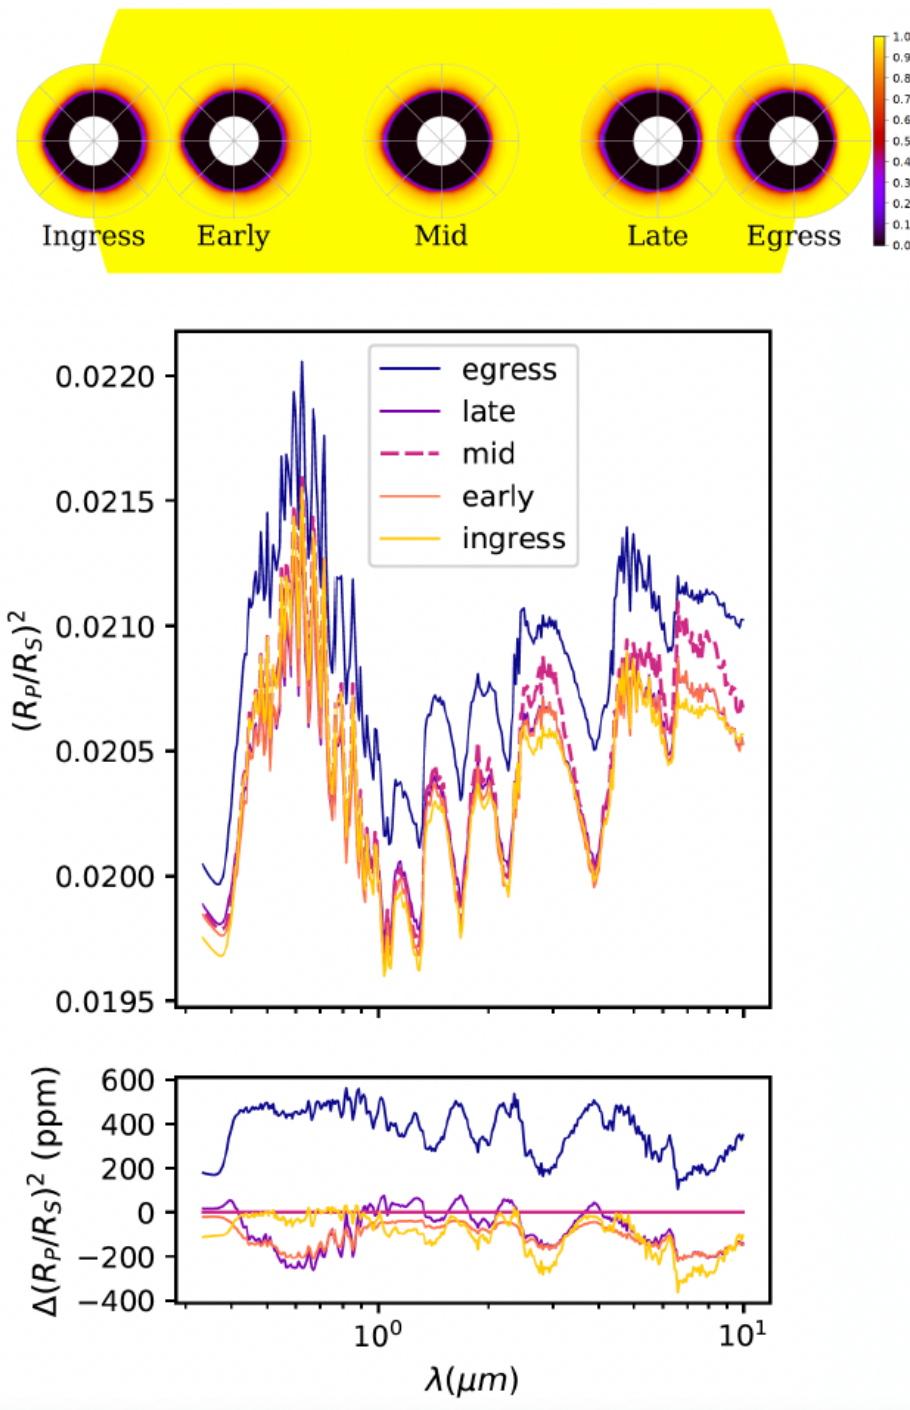
Figure 8. ( Top ) Transmittance maps of WASP-121b at 0.6 microns. The orbital phase angle is − 15 degrees for ingress and +15 degrees for egress. For visual reasons, the planet’s atmosphere has been enlarged with respect to its radius, and the early and late transmittance maps are slightly shifted. Only half of the planet covers the star at ingress and egress. ( Middle ) Spectral variations in the transit depth of WASP-121b during a transit for each phase shown above. ( Bottom ) The difference between each spectrum and the mid-transit spectrum, taken as a reference. During transit, the spectrum varies from tens to hundreds of ppm depending on the wavelength. Such differences are detectable by recent instruments, especially the JWST. Figure adapted from